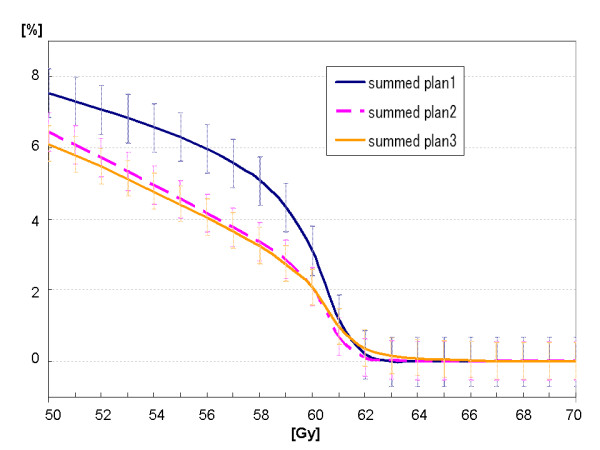
Mean DVH (focused on high dose area (50 to 70 Gy)) of small bowel PRV in each summed plan.